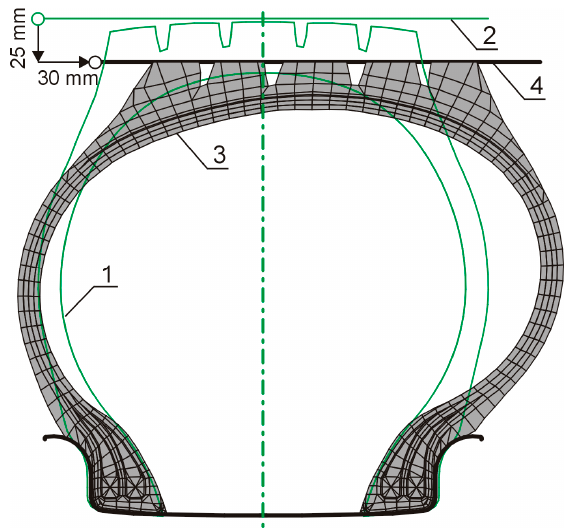
Figure 9. Procedure for determining of tire apparent lateral stiffness: 1 – initial profile of inflated tire; 2 – contacting plane at the initial position; 3 – deformed profile; 4 – contacting plane final position.